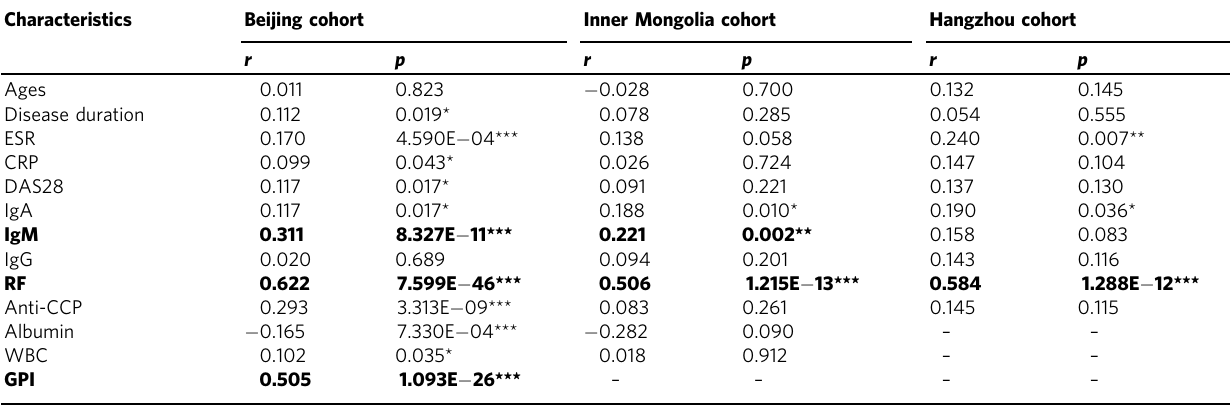
Table 2 Association between sSR-A and RA patient clinical/immunological features.